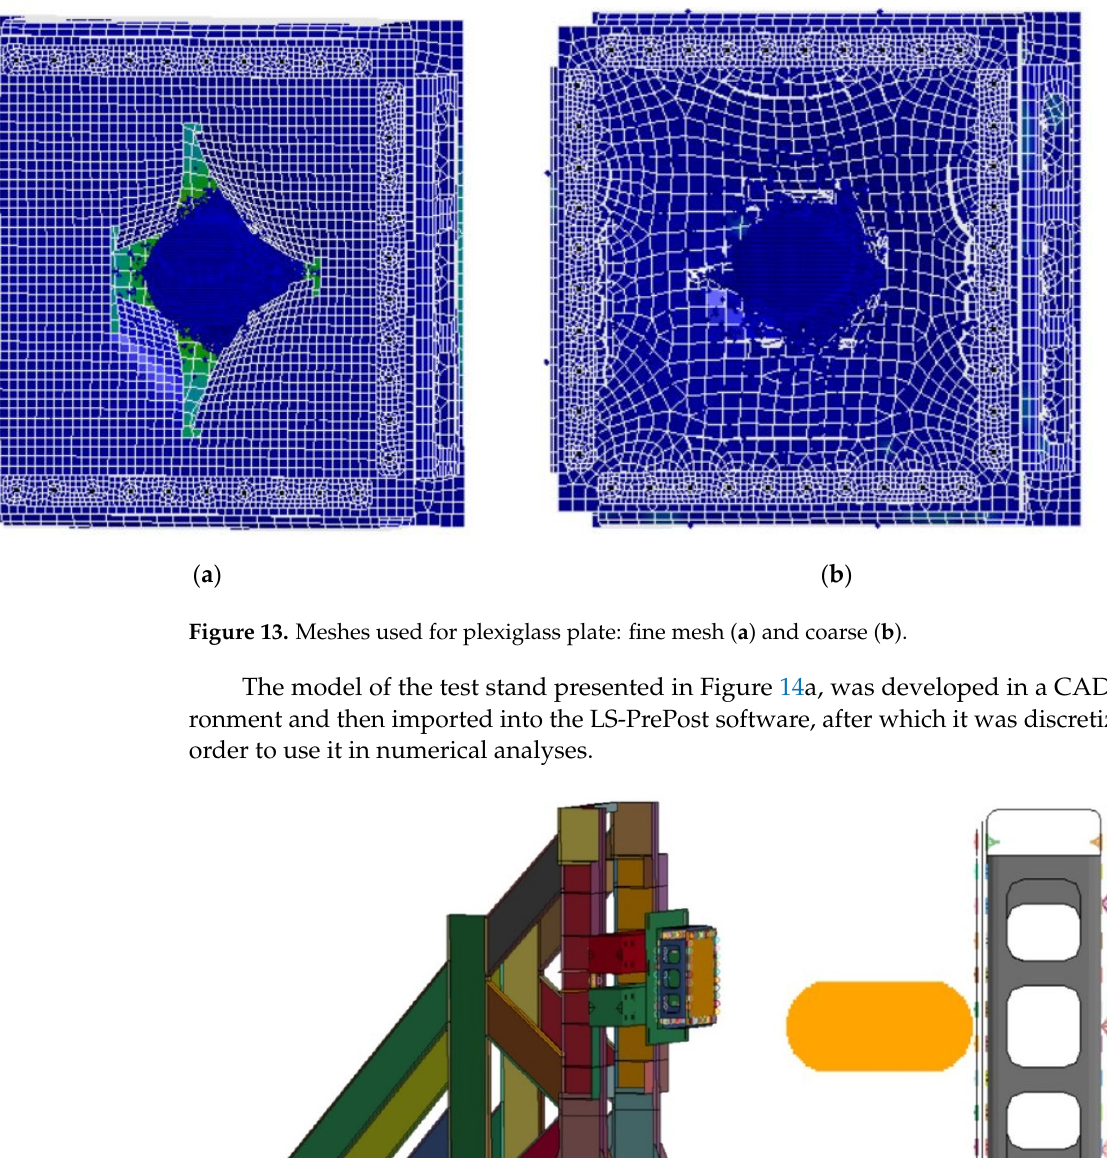
Table 2. Material data used in targets.